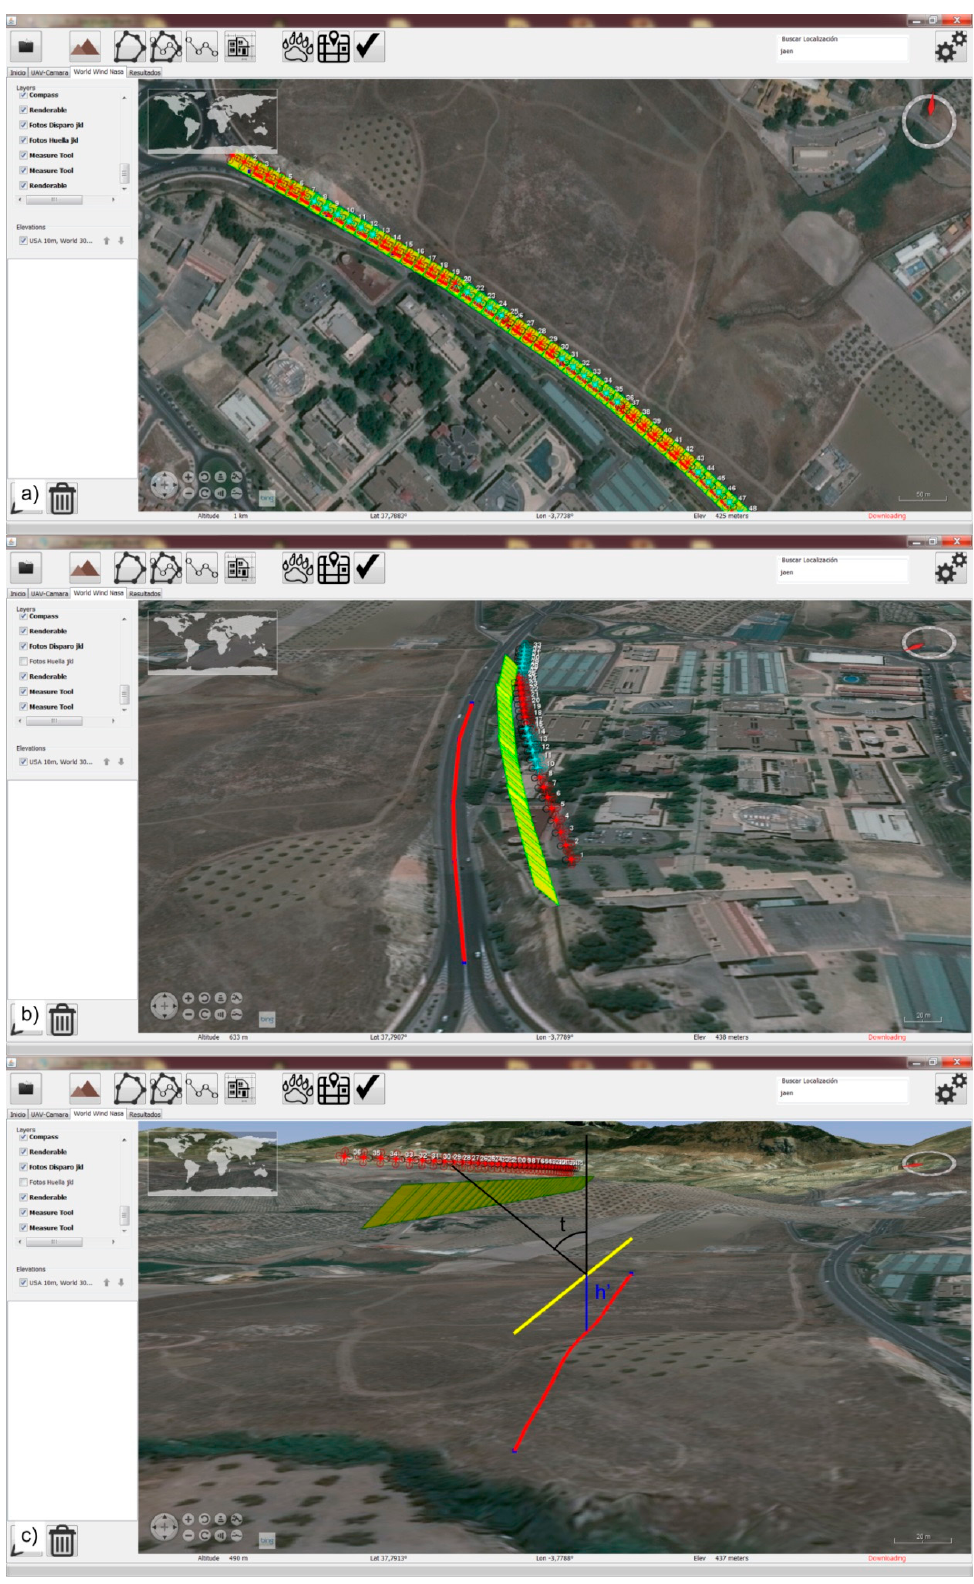
Figure 6. Examples of corridor flights: ( a ) corridor planning based on vertical photographs over the trace; ( b ) tilted images for a linear object; (c) tilted images of the linear object elevated (h’) from the ground.